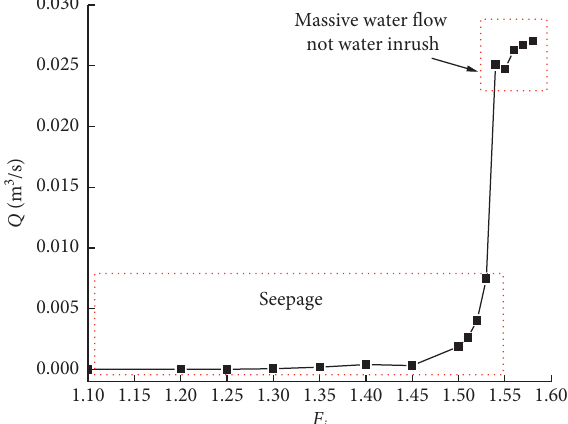
Figure 10: The hydraulic conductivity distribution map when the reduction factor F i � 1.54.